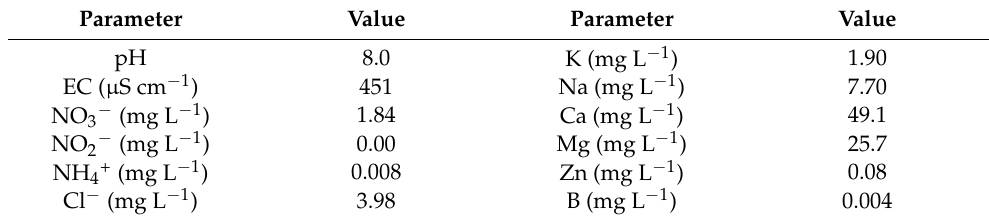
Table 2. Main chemical characteristics of irrigation